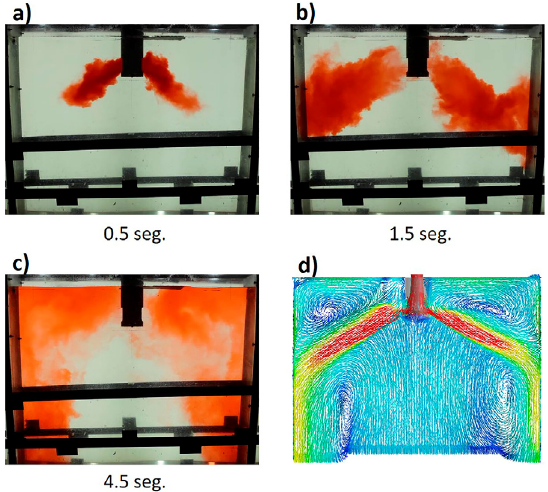
Figure 2. Tracer mixing in the mold model: ( a ) 0.5 s after injection, ( b ) 1.5 s after injection, ( c ) 4.5 s after injection. ( d ) Numerical velocity field.